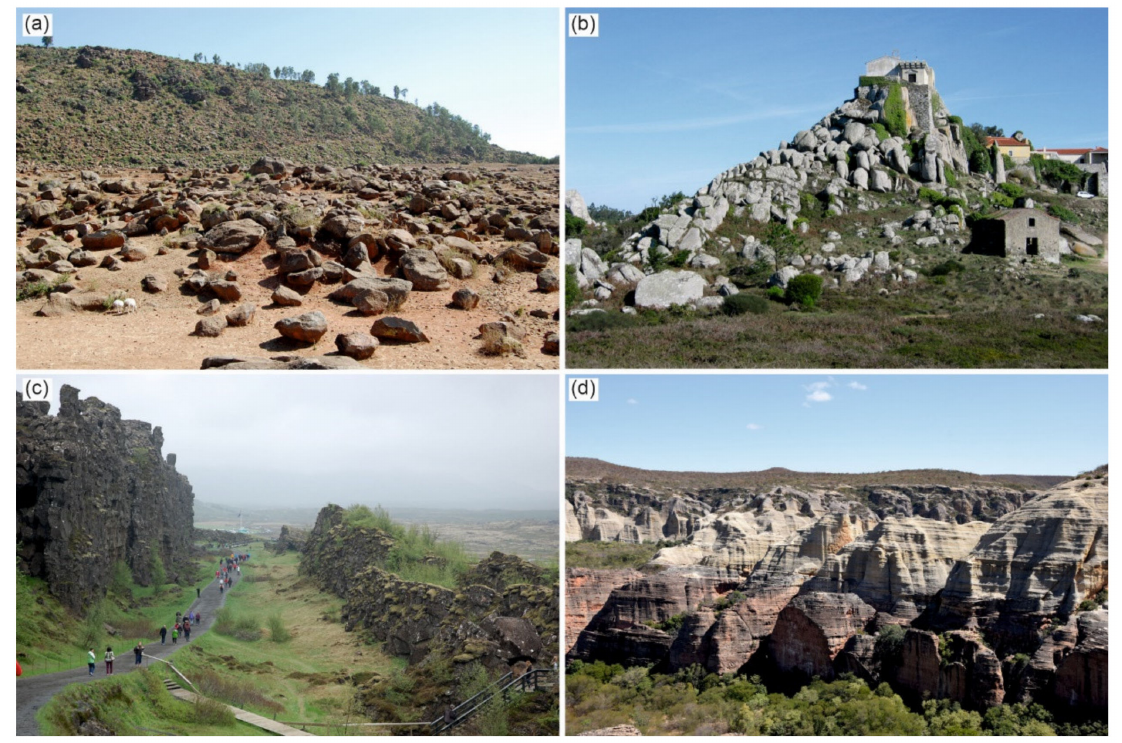
Figure 7. Geoheritage context of selected UNESCO World Heritage cultural properties. ( a ) the archaeological area of Aksum, Ethiopia, with flat-topped syenite plugs, pediments and intriguing boulder fields, ( b ) granite residual hills and boulders in the cultural landscape of Sintra, Portugal, ( c ) graben in the lava plateau at Thingvellir, Iceland, testifies to recent crustal extension at the plate boundary, ( d ) magnificent sandstone and conglomerate cliffs provide the geomorphic context for the rock art site of Serra da Capivara, Brazil (all photographs by the